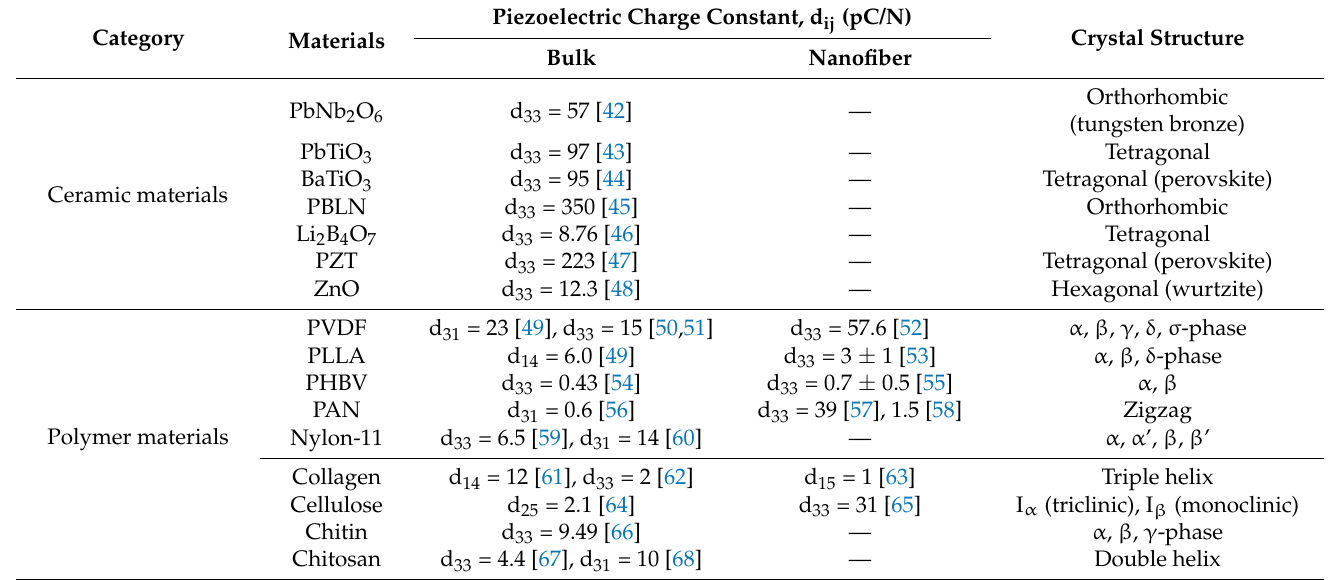
Table 1. Piezoelectric constants and crystal structures of common piezoelectric materials.